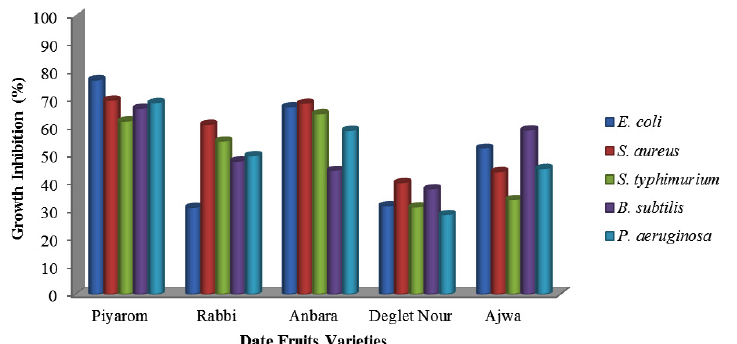
Fig. 2. Antibacterial activity of the selected date fruits varieties against 5 pathogens after the incubation for 24 h at 37 °C